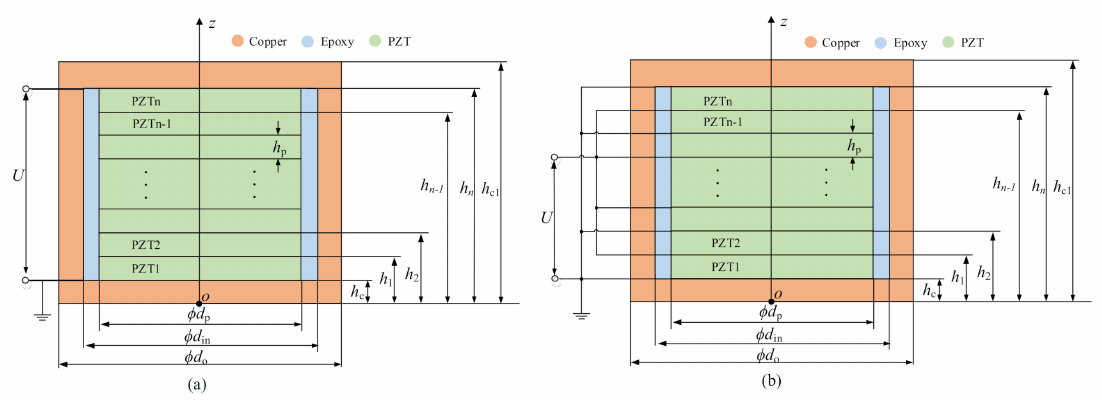
Figure 4. The simplified models of PiSSA actuators: ( a ) wafers in series connection; and ( b ) wafers in parallel connection.